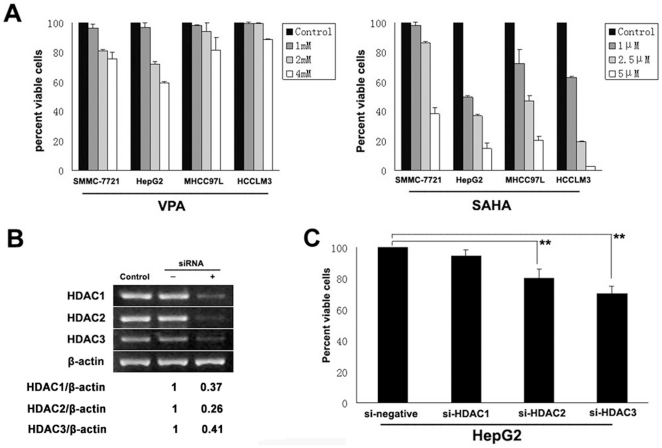
Antiproliferative effects of chemical HDAC inhibitors and selective HDAC1, 2, 3 silencing in HCC cells.(A) Treatment with either VPA or SAHA led to a significant dose-dependent reduction of HCC cell numbers after 72 h. (B) Effective silencing of HDAC1, 2, 3 mRNA in HepG2 after siRNA treatment for 48 hours. (C) Selective knockdown of HDAC3 and HDAC2 led to reduction of HepG2 cell numbers after 72 hours (**P<0.01, Student t test).